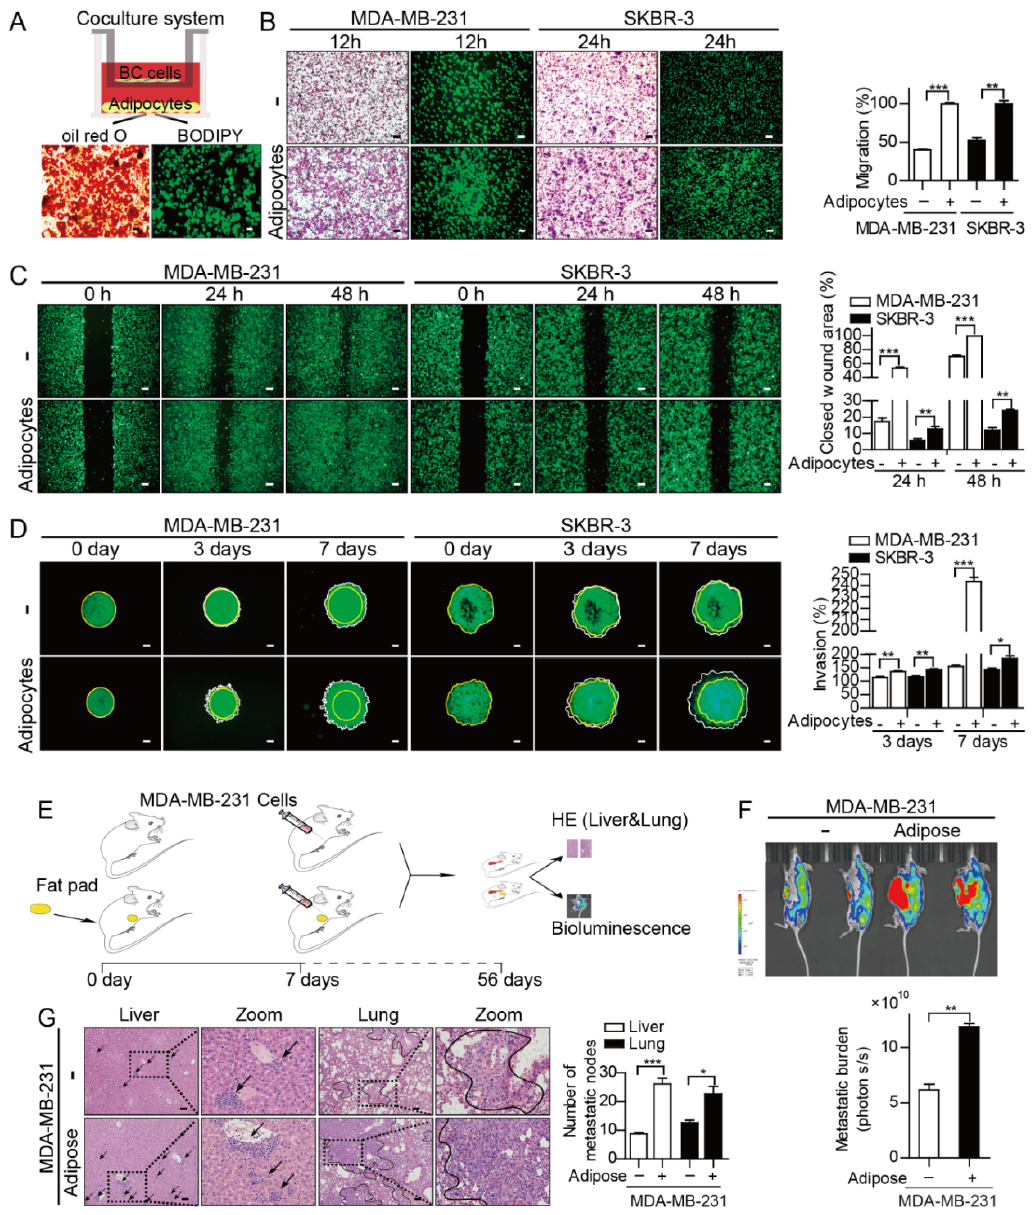
Figure 1. Adipocytes potentiate breast cancer metastasis. ( A ) Coculture system of adipocytes and breast cancer cells (BC cells). ( B ) Transwell migration assays of GFP-labeled cancer cells were performed for 12 h or 24 h after cocultured with adipocytes or monoculture for 72 h. The migratory cells were fixed and stained with a Di ff -Quick stain kit. Bars represent the means ± SEMs from three independent experiments. ( C ) The wound healing rate was measured at 24 h and 48 h in MDA-MB-231 and SKBR-3 cells in the presence or absence of adipocytes for 72 h. Bars represent the means ± SEMs from three independent experiments. ( D ) 3D matrix invasion assays were employed to detect the invasion capacity of MDA-MB-231 and SKBR-3 cells on day 3 and day 7 after cocultured with mature adipocytes for 3 days. Yellow and white circles represent the center of the spheroid and the perimeter of cancer cells in a spheroid, respectively. The results are presented as the means ± SEMs from three independent experiments. ( E ) Formation of the breast cancer metastasis model. ( F ) Representative images and quantitative results of bioluminescence in metastatic tumor mice. ( G ) H&E-stained liver and lung sections from the indicated mouse groups. Arrows and circles indicate representative metastases of breast cancer. The number of metastases is shown as the means ± SEMs ( n = 6). Scale bar = 100 µ m. * p < 0.05, ** p < 0.01, *** p < 0.001.